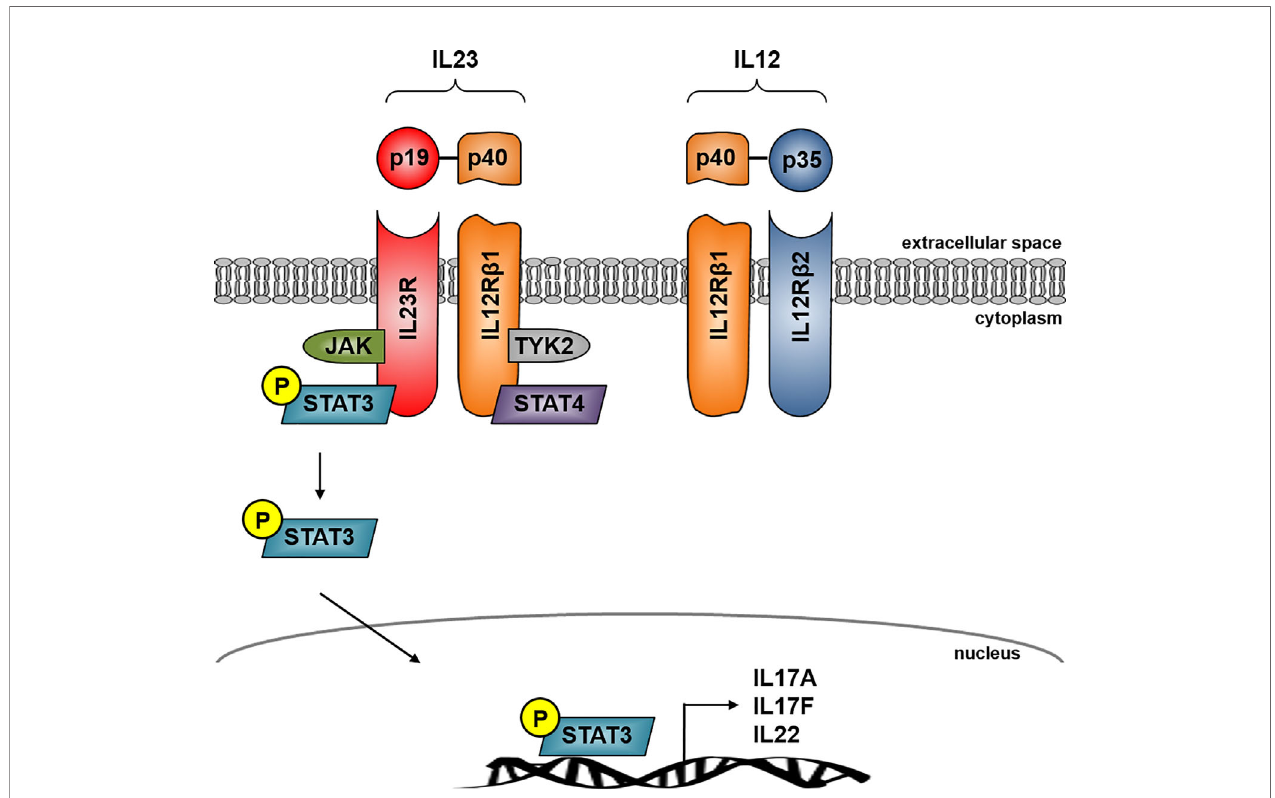
FIGURE 1 | IL23 signaling in Crohn ’ s disease. IL23 is a heterodimer consisting of the unique subunits p19 and p40, the latter is shared with IL12. IL23 signals through its heterodimeric receptor complex consisting of the two subunits IL12R b 1 and IL23R whereas IL23R is the unique subunit and IL-12R b 1 shares the IL12 receptor complex. The IL23R complex signals through JAK kinase and STAT transcription factors. IL23 binding to its receptor activates Jak2 and Tyk2 kinases which then phosphorylates the receptor to form a docking site leading to the subsequent phosphorylation of STAT3 for the p19 subunit and STAT4 for the p40 subunit. IL23R signaling activates several pathways leading to transcription of several effector cytokine genes in CD including IL17A, IL17F and